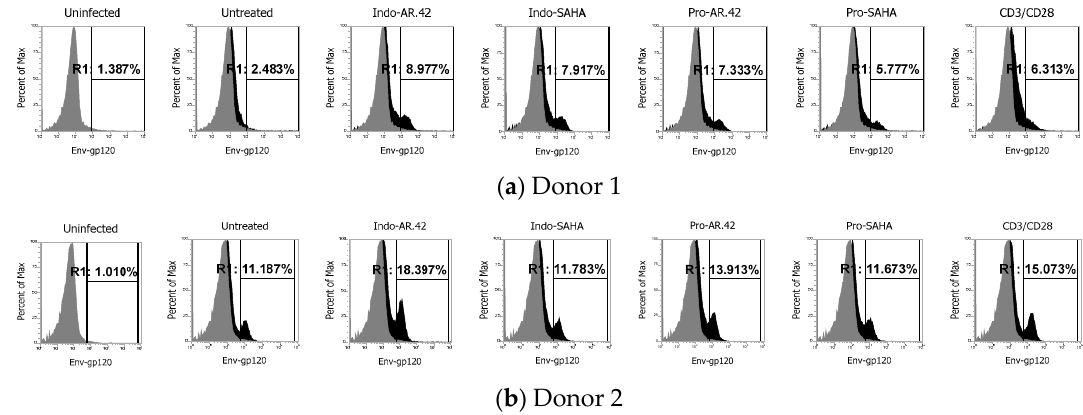
Figure 10. Effect of combinations of LRAs on gp120 expression in HIV latently infected cells. Total CD4+ T-cells were treated with CCL19 and infected with HIV NL4-3. Seven days post-infection, the cells were either treated with combinations of LRAs or left untreated, while positive control cells were induced with Dynabeads Human T-Activator CD3/CD28. Cells were incubated with anti-HIV-1 gp120 mAb NIH45–46 G54W, and the gp120 expression was evaluated using flow cytometryfollowing 48 h treatment. ( a , b ) Single peak of Env expression of uninfected cells and overlays of Env expression of untreated cells with untreated infected cells and cells treated with the combinations indolactam / AR-42, indolactam / SAHA, prostratin / AR-42, prostratin / SAHA and T-Activator CD3 / CD28 from two di ff erent